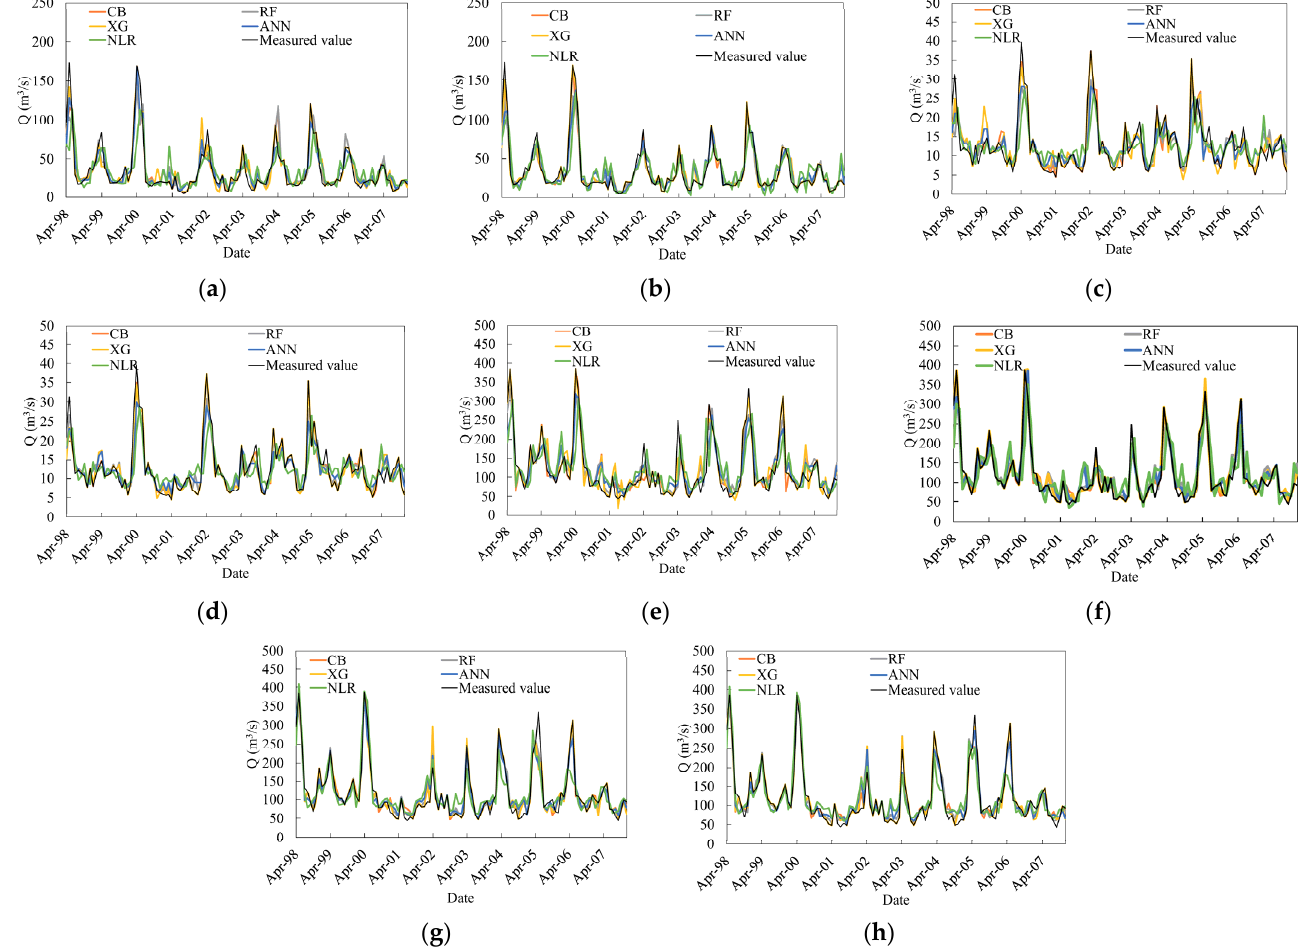
Figure 6. Time variation graphs of the observed and predicted stream flows by CB, RF, XG, ANN and NLR: ( a ) Durucasu (S 1 M), ( b ) Durucasu (S 1 MP) ( c ) Sutluce (S 1 M), ( d ) Sutluce (S 1 MP), ( e ) Kale (S 1 M), ( f ) Kale (S 1 MP), ( g ) Kale (S 1314 M) and ( h ) Kale (S 1314 MP).